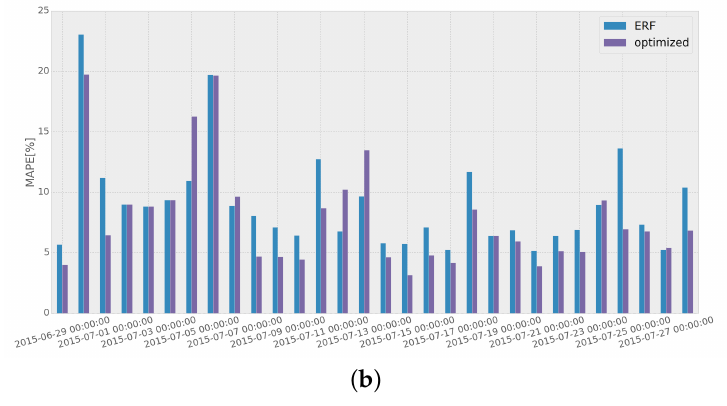
Figure 13. Comparison of the performance with and without using the adaptive Short-Term Load Forecasting (STLF) algorithm: ( a ) Network 1 and; ( b ) Network 2.